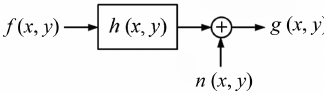
Figure 3. Image degradation model of motion blur